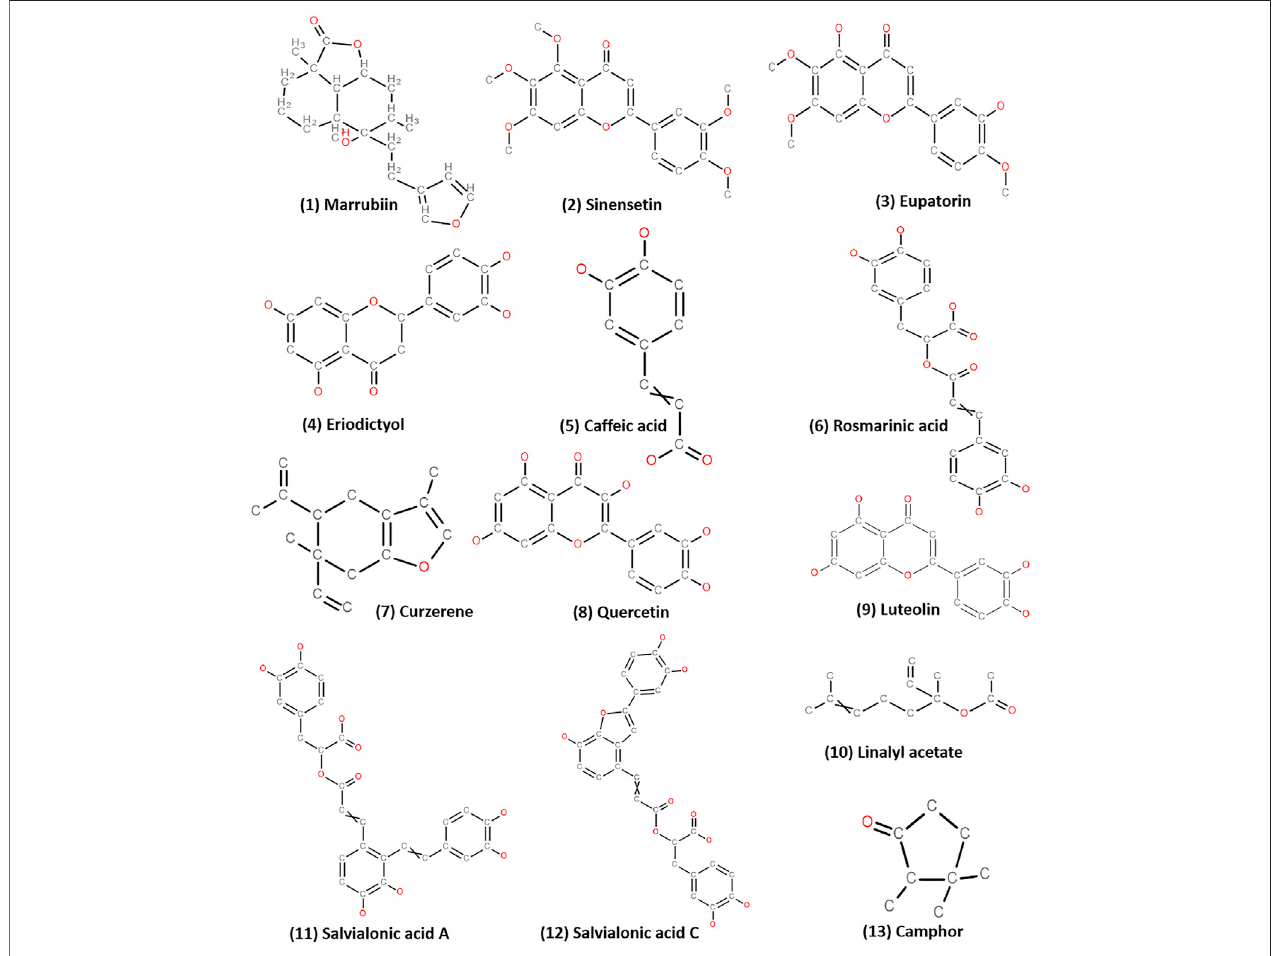
FIGURE 3 | Bioactive compounds from Lamiaceae that can be derived as potential lead drugs for the treatment of CVDs (Biovia software was used to prepare chemical structures https://www.3ds.com/products-services/biovia/products/scienti fi c-informatics/biovia-draw/).